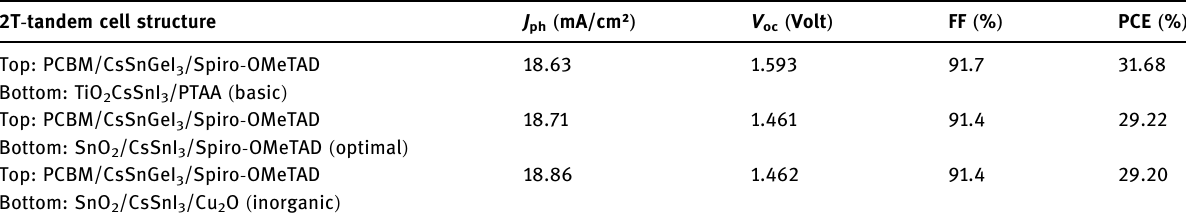
Table 2: Performance of CsSnI 3 - based perovskite cell structures 2T - tandem cell